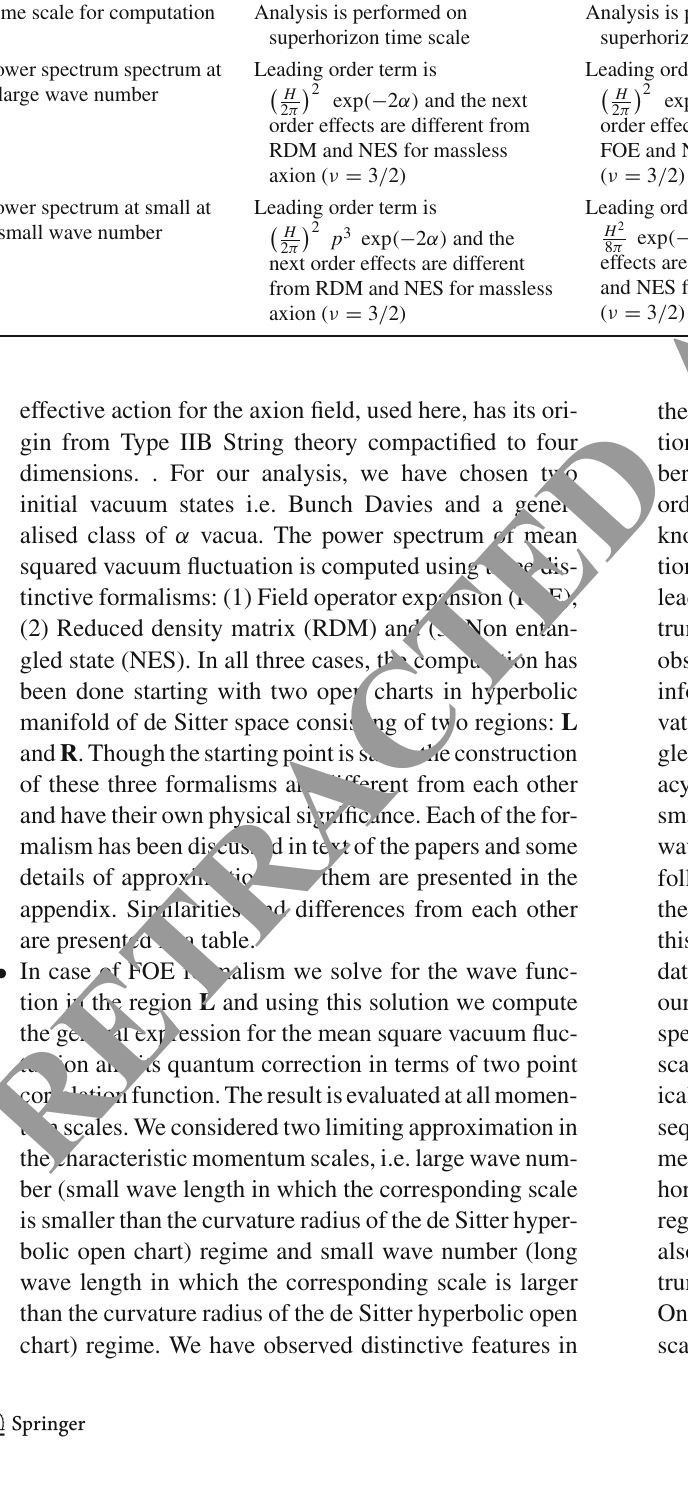
Here we only solve the wave function in L region of dS space Here we deal with non-entangled quantum state Power spectrum is only dependent on SO(1,3) quantum number p and independent on l,m Analysis is performed on superhorizon time